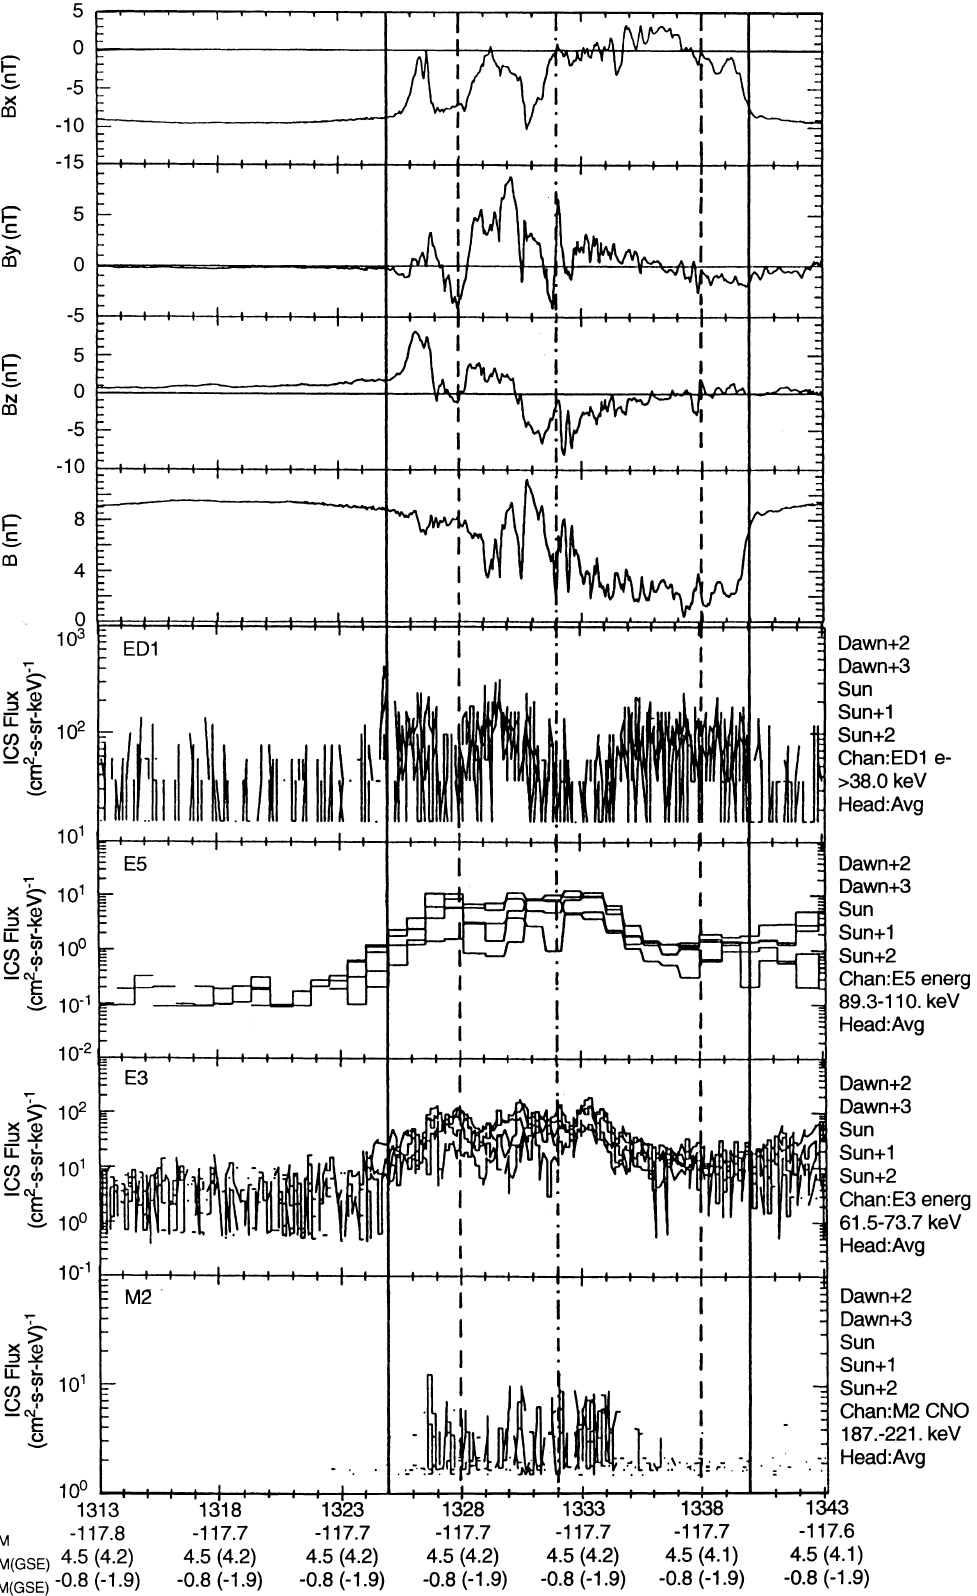
two dashed vertical lines indicate the start (1328 UT) and the end times (1338 UT) of convection interval. The Earthward edge of the bipolar B z signature detected at 1332 UT is marked by the vertical dashed- dotted